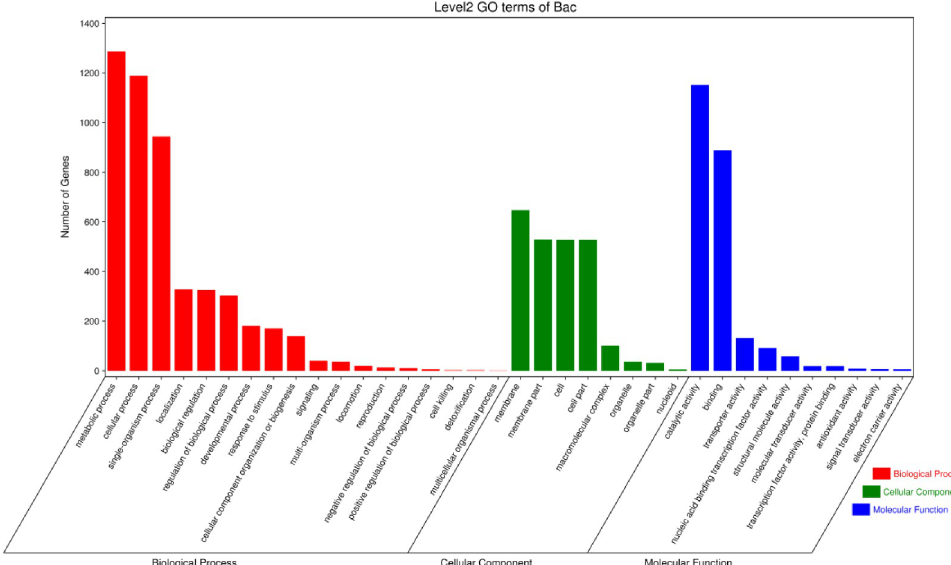
Fig 9. GO classification of bacterial gene function